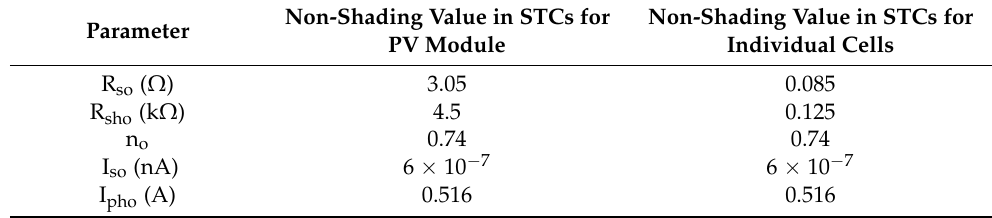
Table 2. The equivalent circuit parameters of the 10 W PV module under an irradiance of 1000 W/m 2 measured at the centre of the module and at a module temperature of 25 ◦ C. The series and shunt resistances for the individual cells were obtained by dividing R so and R sho by the number of cells. The parameters of the individual cells were used as the non-shading reference in the model for calculation of the shading influence. The data was extracted from the experimental I-V curve, based on the average of three